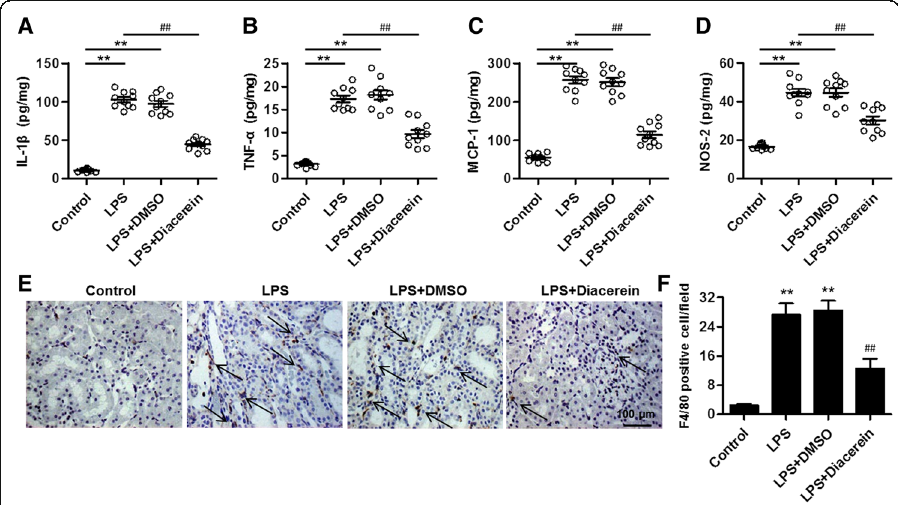
macrophage infiltration in kidney tissues, as evident by a 54% reduction compared with LPS-treated mice alone (Fig. 3e and f).